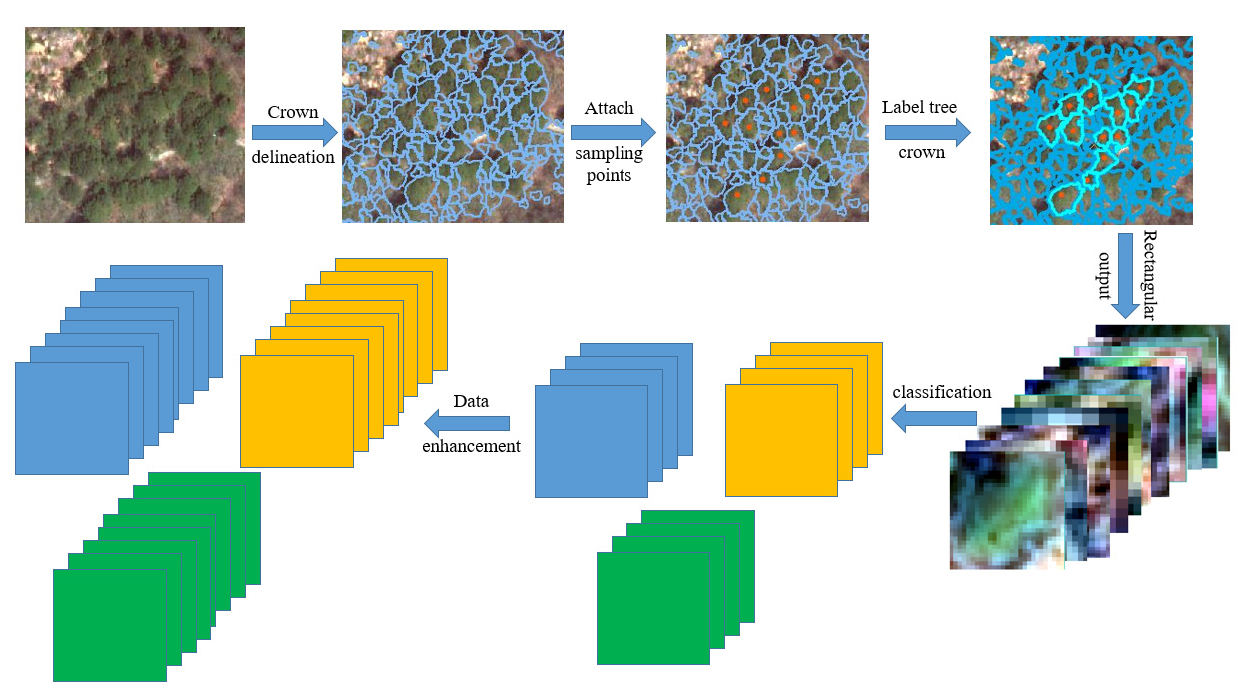
Figure 4. Schematic diagram of the steps in building the ITS sample set.